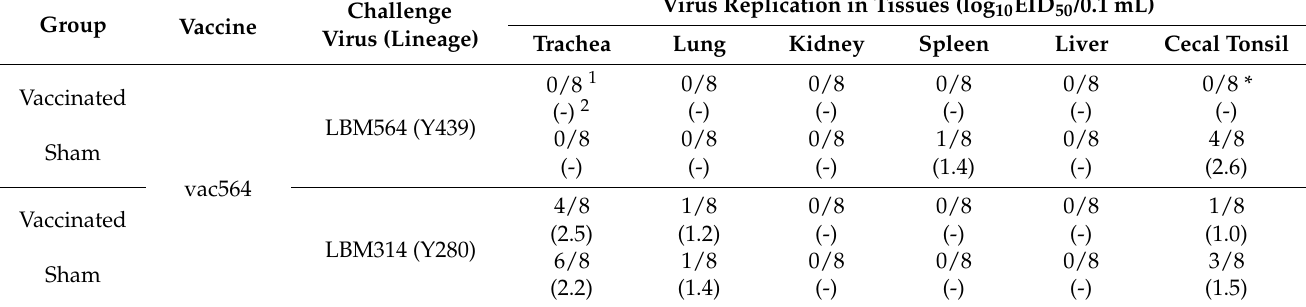
Table 4. Virus replication in tissues from vaccinated SPF chickens challenged with Y439 and Y280 lineage H9N2 viruses